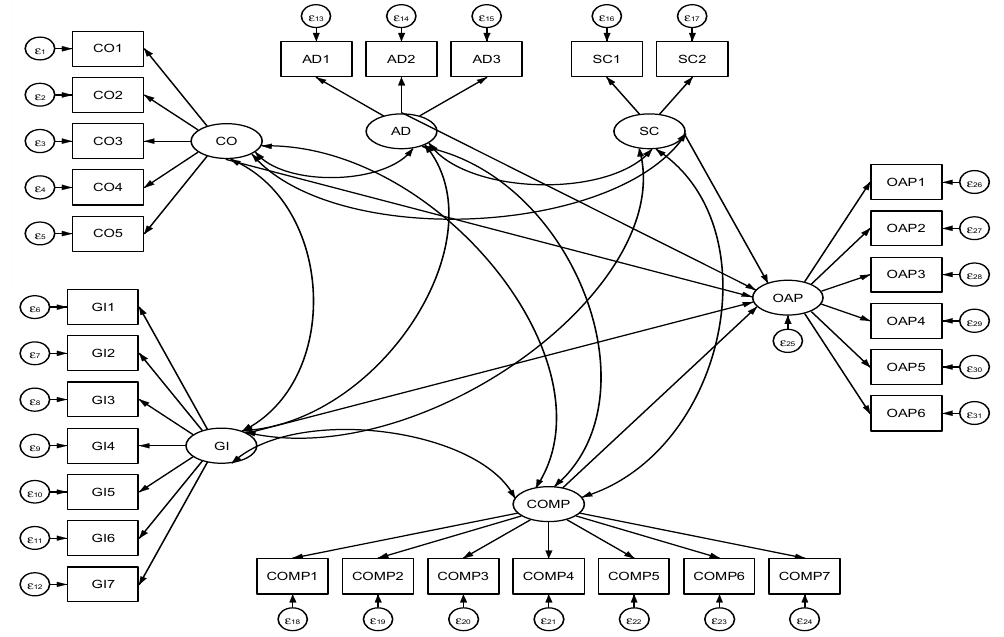
Figure 2. Path diagram of direct and indirect impacts of institutional features on WUAs’ performance.